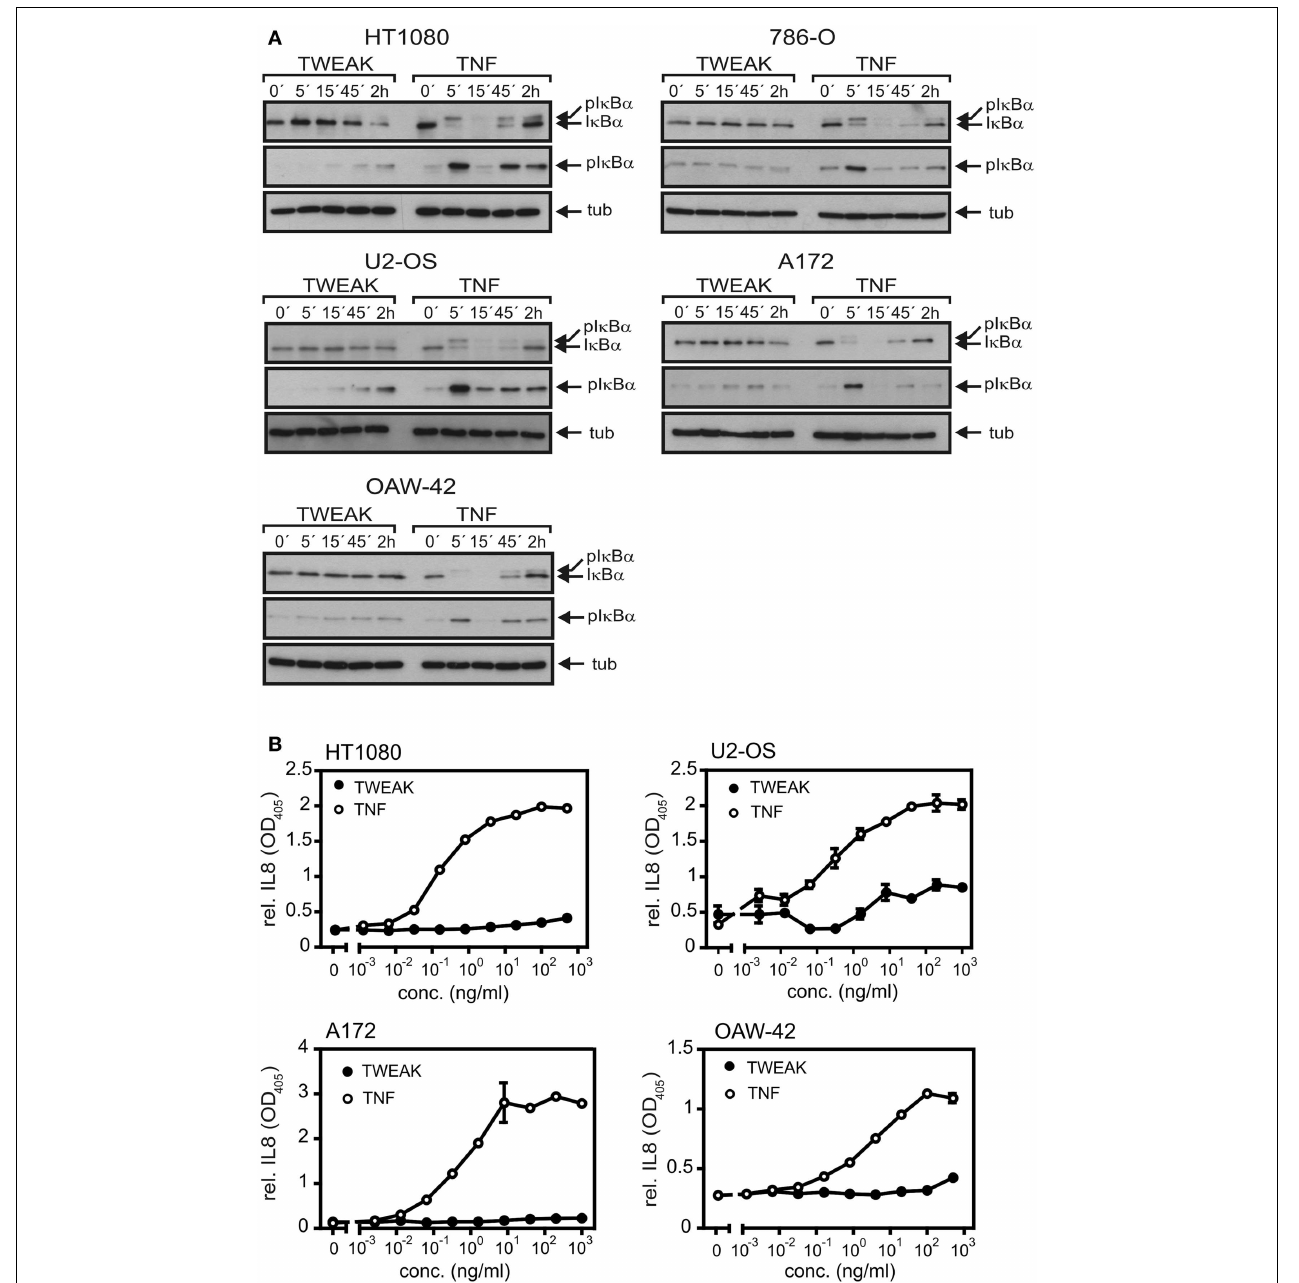
FIGURE 1 |TNF is superior to solubleTWEAK in activation of the classical NF κ B pathway . (A) The various cell lines were stimulated for the indicated times with Flag-TNF (100ng/ml) and Flag-TWEAK (200ng/ml) and total cell lysates were then analyzed for the presence of phospho-I κ B α and total I κ B α .